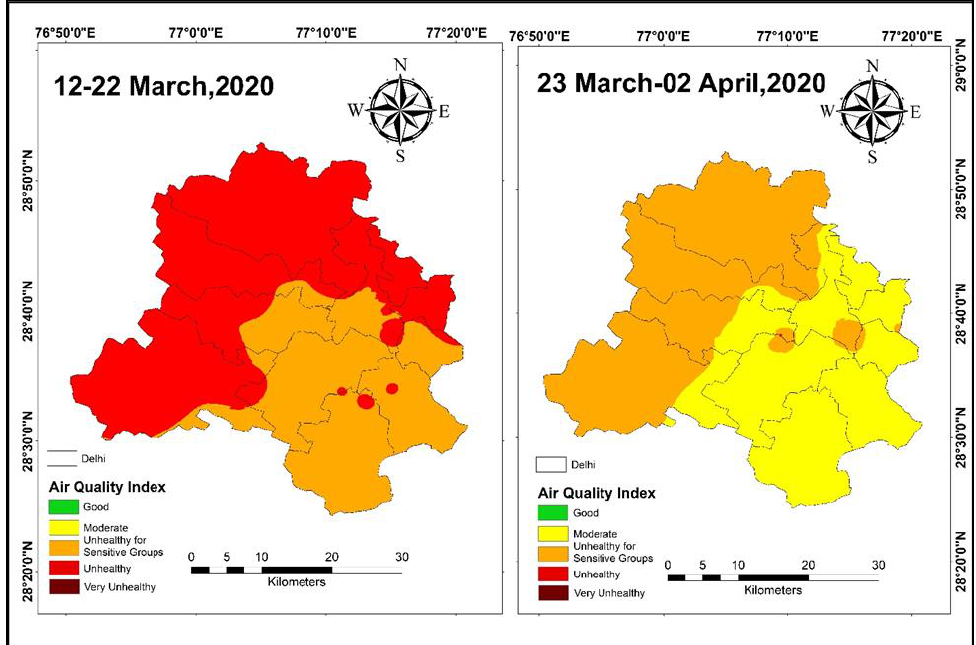
Figure 7. AQI map of PM 2.5 before (12-22 March, 2020) and during the lockdown (23 March – 02 April, 2020).